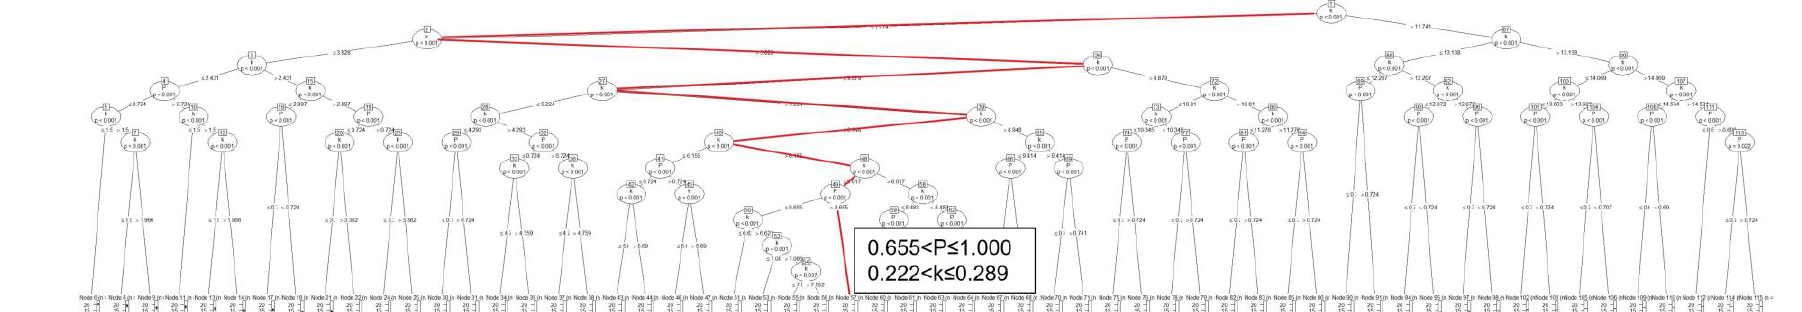
Figure 6. Binary decision tree for the PM2.5 decay scenario of Case I.